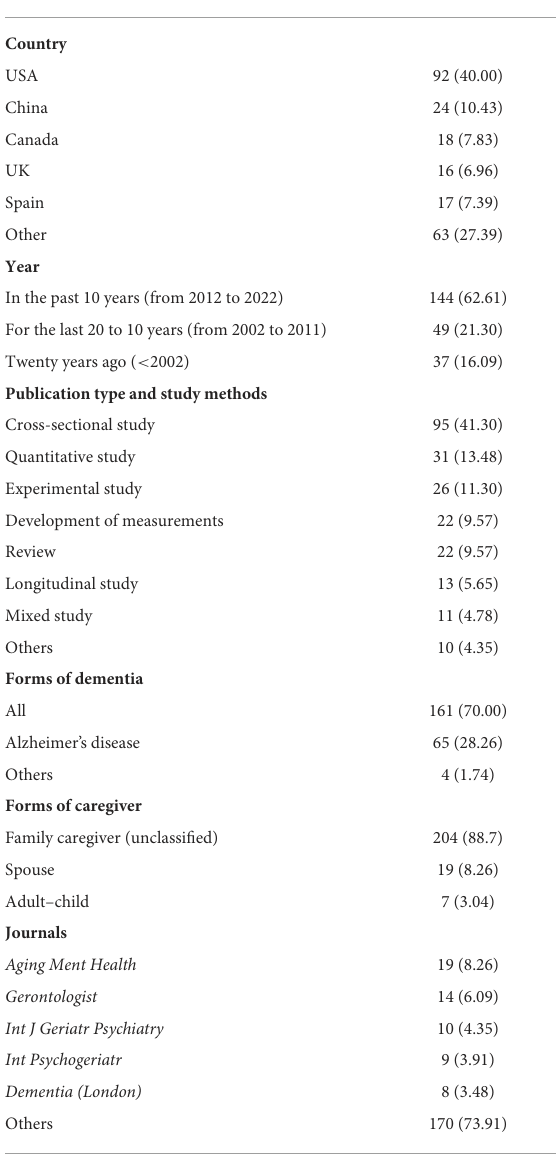
TABLE 1 Summary of key characteristics of included